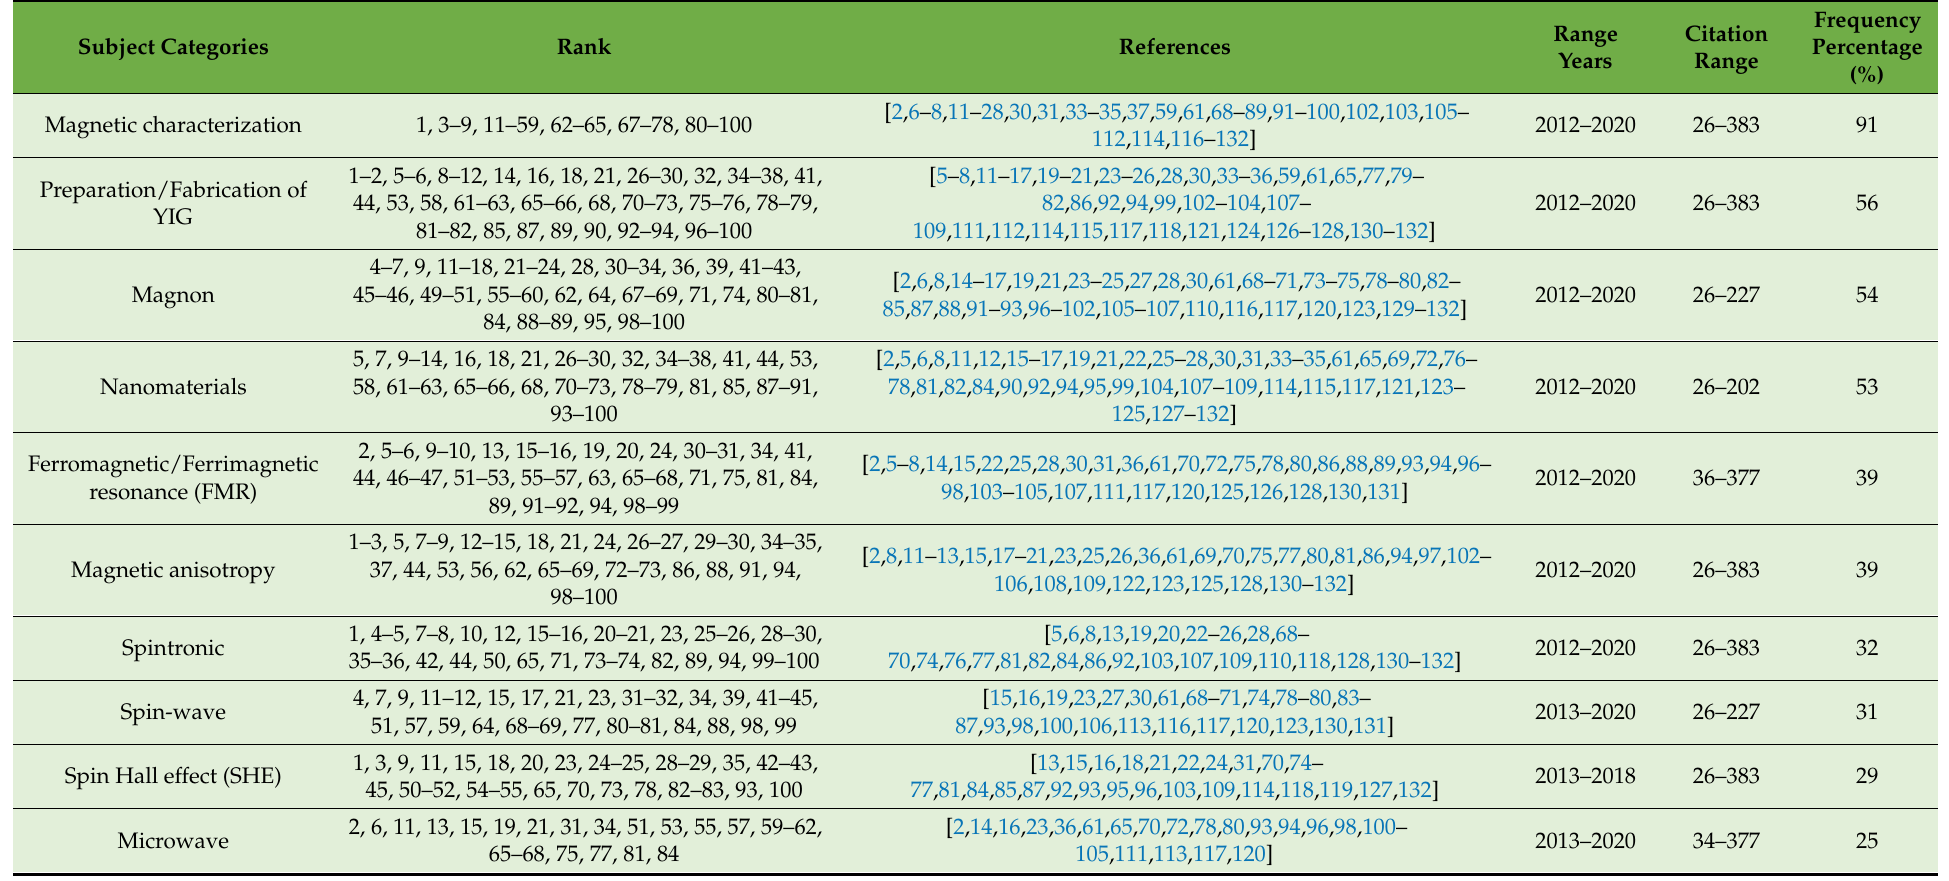
Table 3. Distribution of subject categories for the top 100